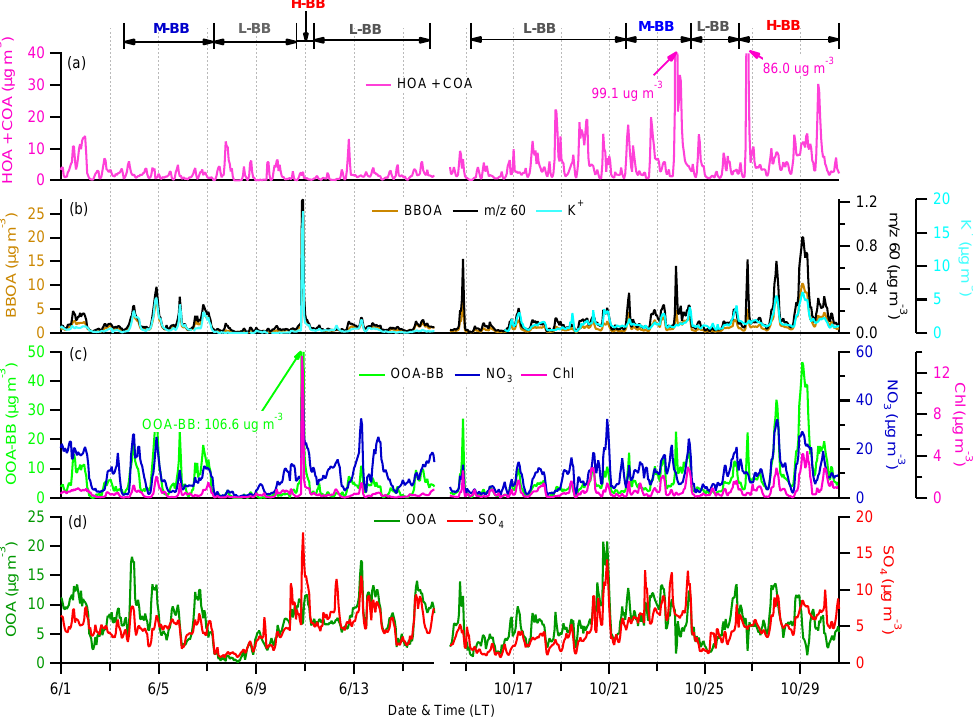
Figure 4. Time series of OA factors (left) and relevant tracer species (right): (a) HOA + COA; (b) BBOA and a surrogate of levoglucosan ( m/z 60) and potassium ion (K + ) ; (c) OOA-BB, nitrate and chloride; (d) OOA and SO 4 . Note that different BBOA mass concentrations for a low biomass-burning period (L-BB), medium biomass-burning period (M-BB), and high biomass-burning period